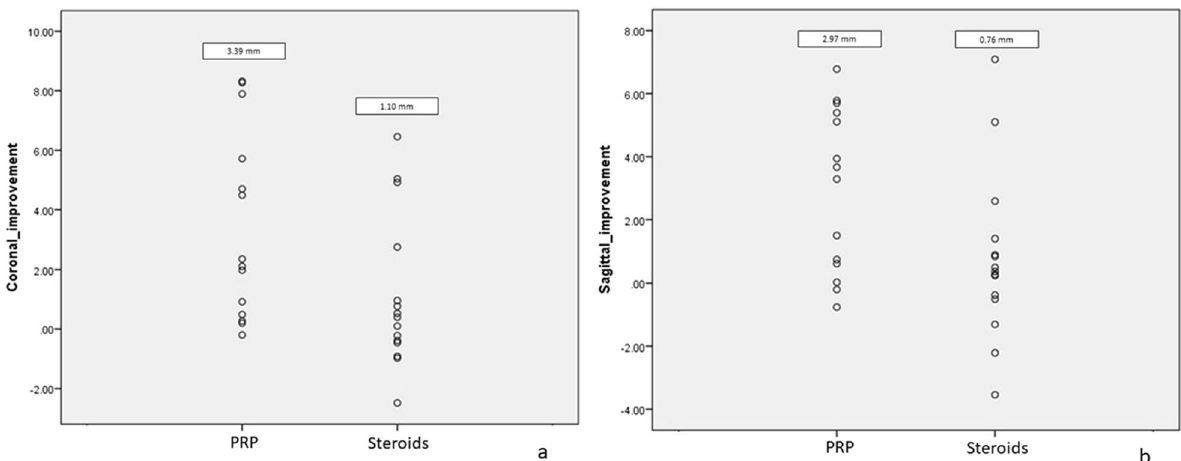
Fig. 3 Dot plots show tear size reduction in the coronal plane ( a ) and sagittal plane ( b ) after PRP and steroids